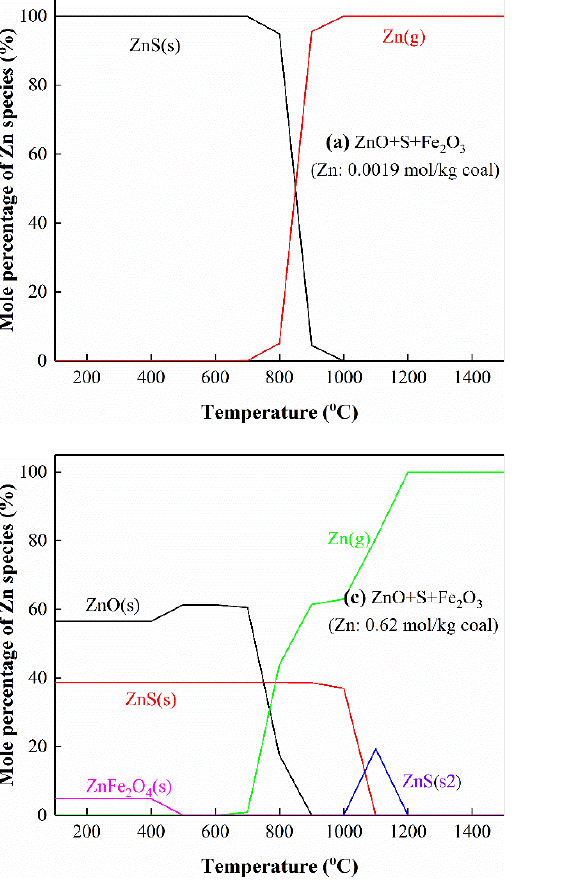
Figure 9. The thermodynamic equilibrium distributions of Zn ( a , c ) and Fe ( b , d ) when S, Zn and Fe coexist in the coal.